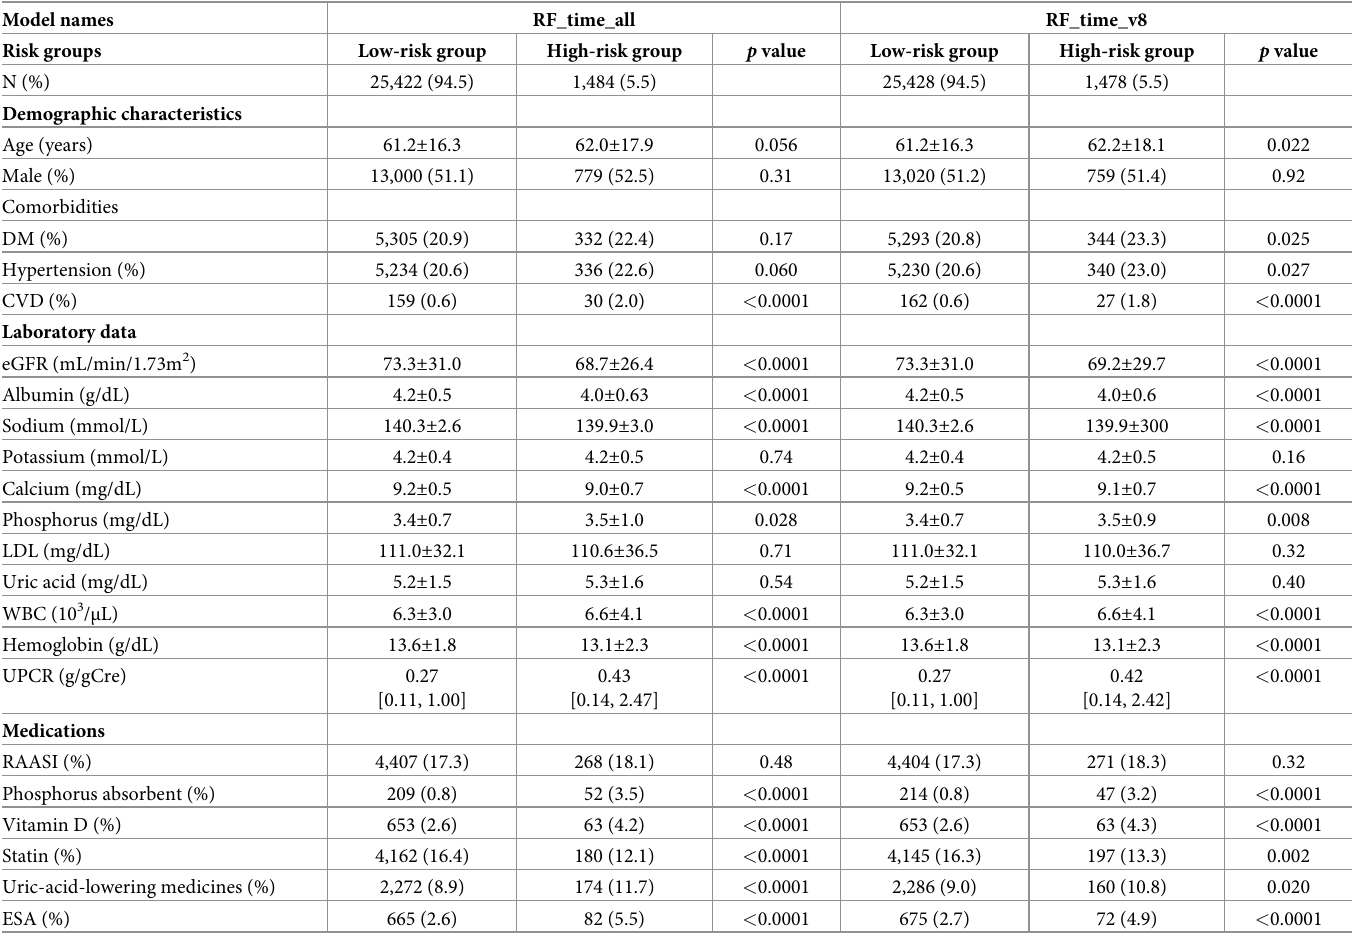
Table 1. Baseline characteristics of risk groups classified on the basis of the results of machine-learning models.